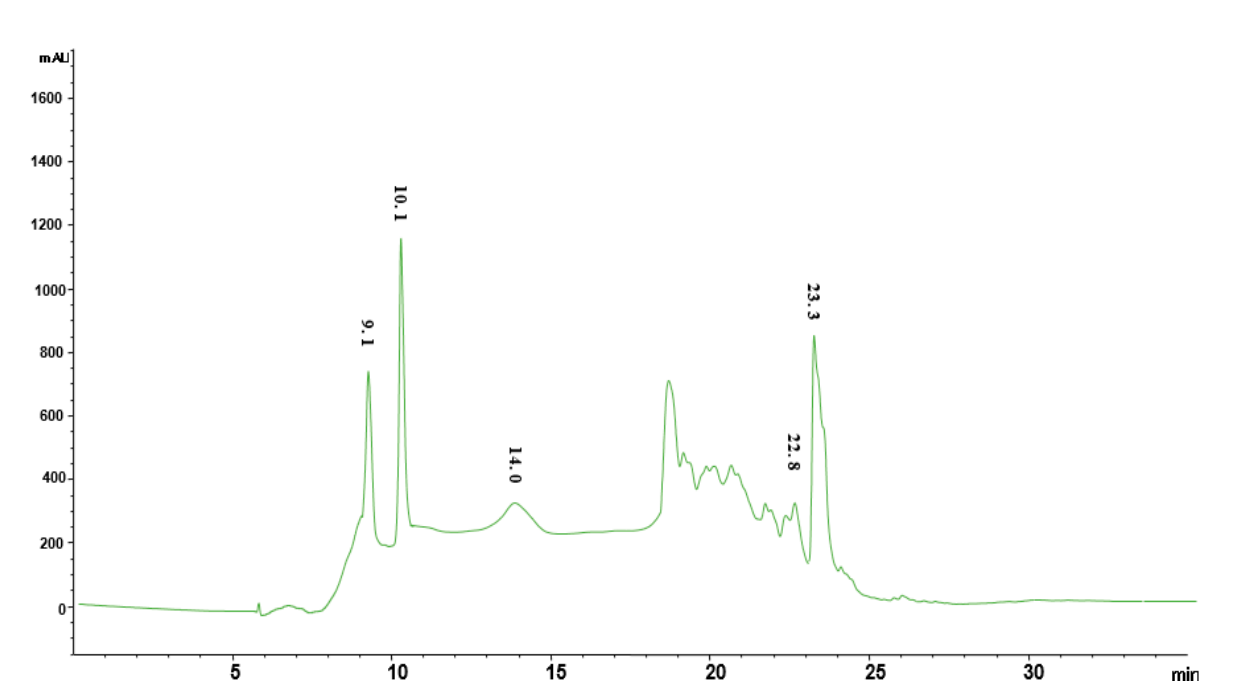
Figure 8. HPLC chromatogram of the PHMF2 subfraction at 280 nm. (1) quinic acid, (2) peganine, (3) harmol, (4) harmaline, and (5) harmine. Table 5. Quantification of quinic acid, peganine, harmol, harmaline, and harmine of PHMF2 obtained from Peganum harmala RP-HPLC subfraction.